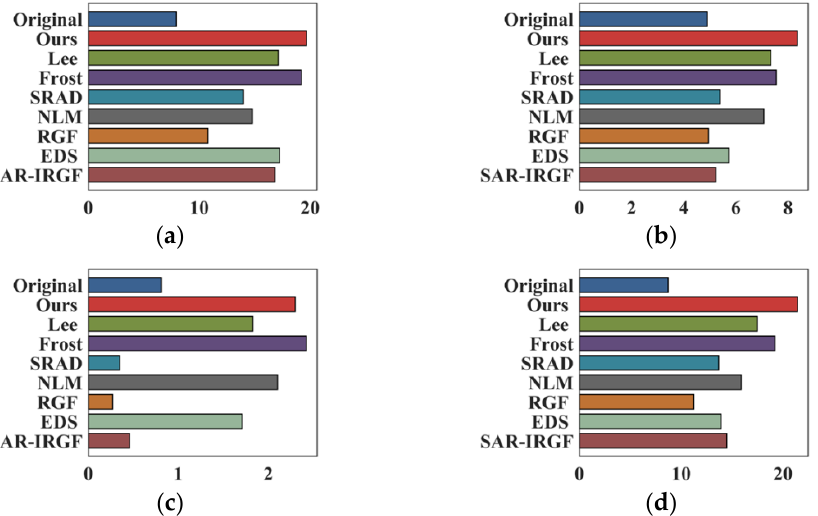
Figure 12. ENL results for the regional parts of speckle suppression images: ( a – d ) are the ENL results of subregion 1, subregion 2, subregion 3, and subregion 4, respectively, in the synthetic image.